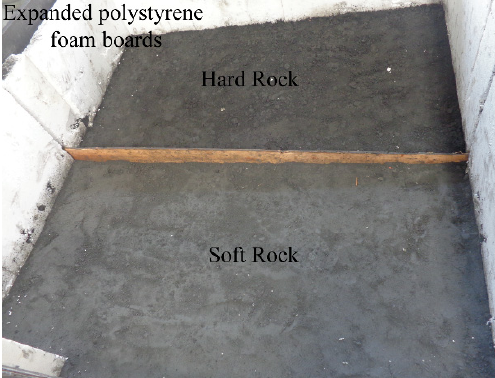
Figure 9. Model soil interface control.